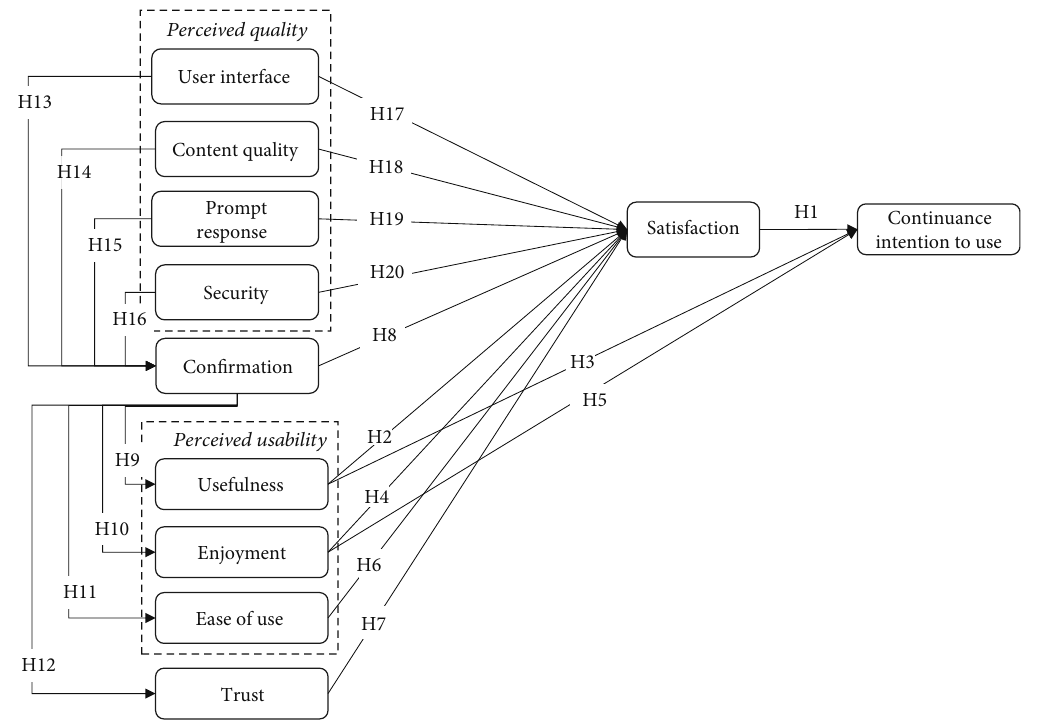
Figure 1: Research